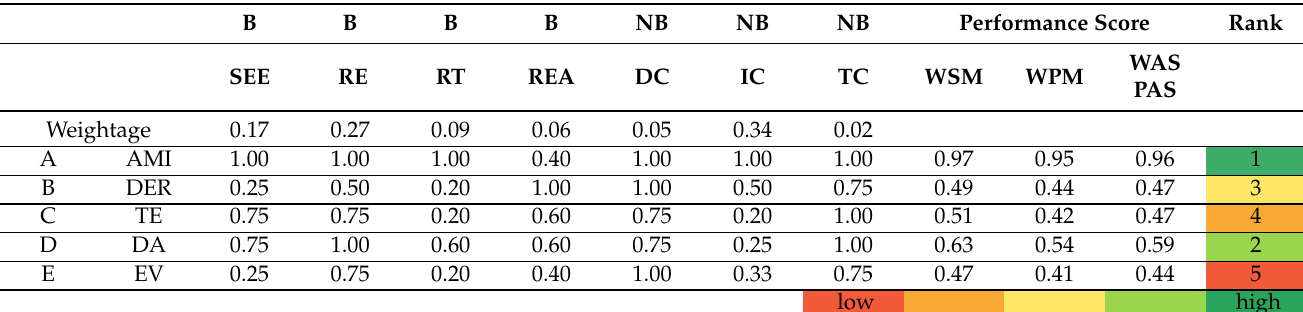
Table 20. MCDM operation with the Linear Normalization. B ≡ Beneficial, NB ≡ Non-Beneficial. SEE ≡ System Efficiency Enhancement, RE ≡ Reliability Enhancement, RT ≡ Reduced Theft, REA ≡ Renewable Energy Adoption, DC ≡ Deployment Challenges, IC ≡ Investment Cost, TC ≡ Technological Challenges. The Linear Normalization Formula for NB: LN ( x ij ) NB